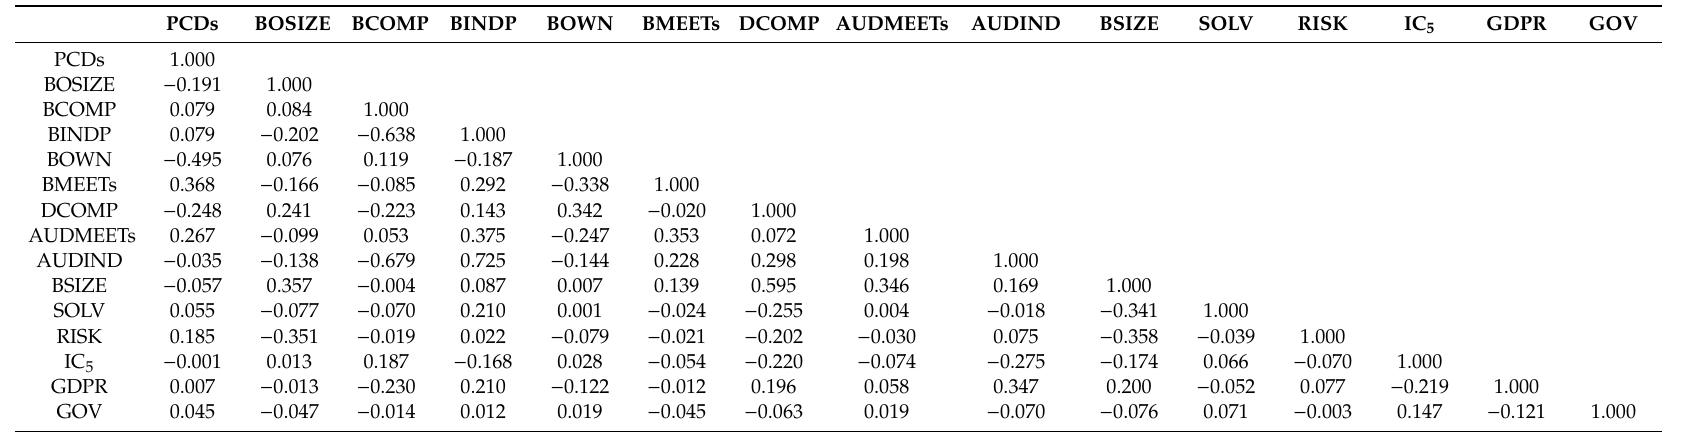
Table 3. Correlation